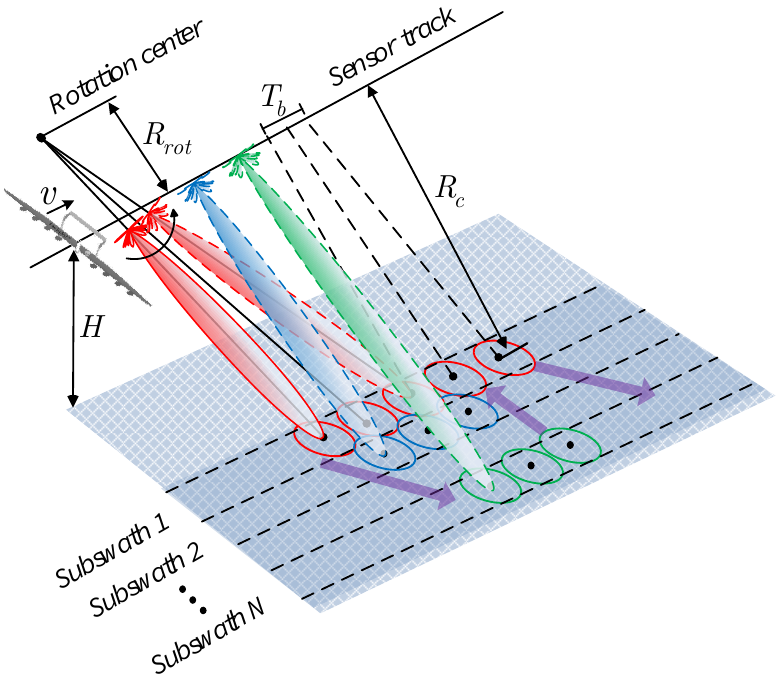
Figure 2. Geometry model of near-space terrain observation by progressive scans SAR